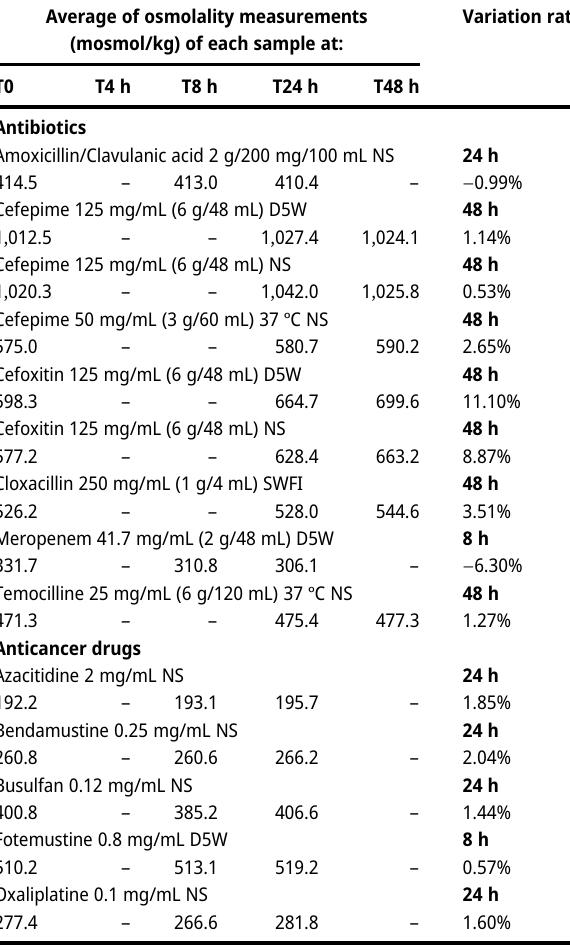
Table  : Average of osmolality measurements (mosmol/kg) of each